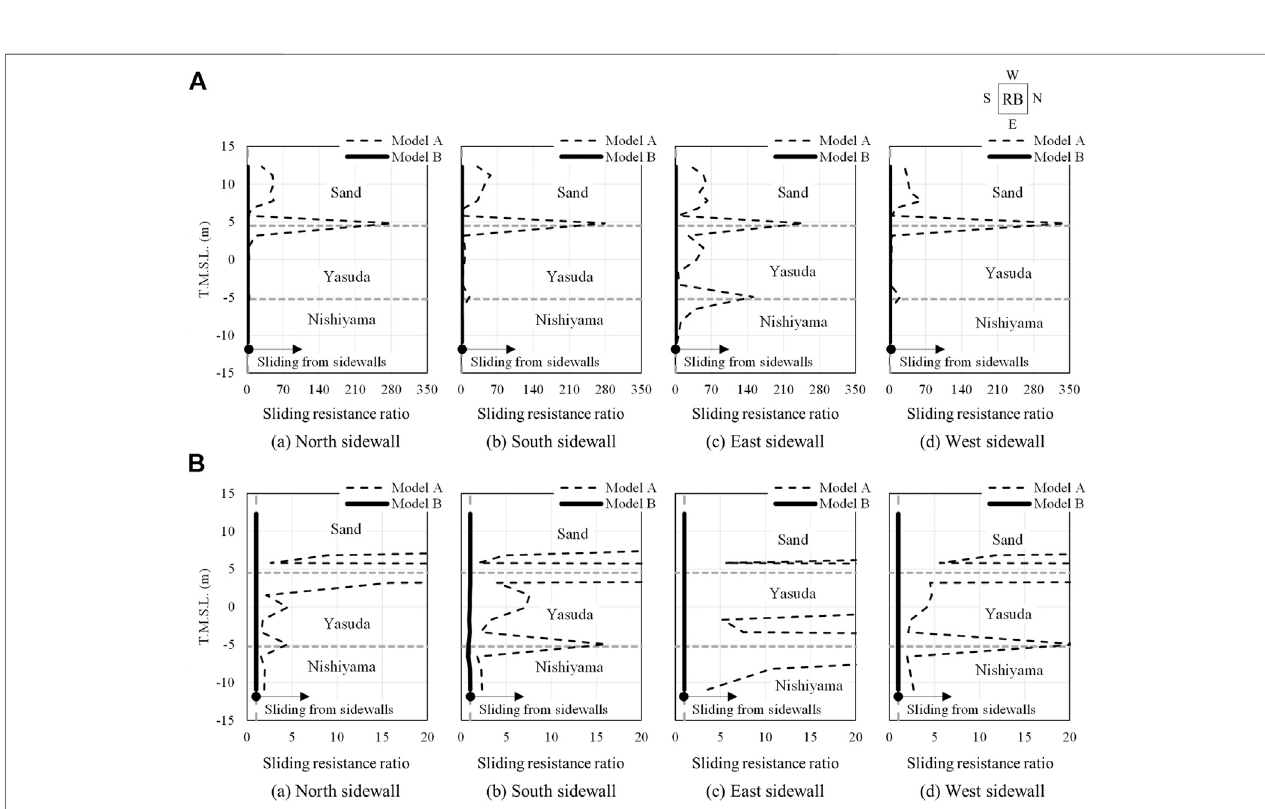
FIGURE 13 | Soil pressure characteristics of sliding resistance ratio acting on sidewalls (A) Ratio from 0 to 350. (B) Ratio from 0 to 20.